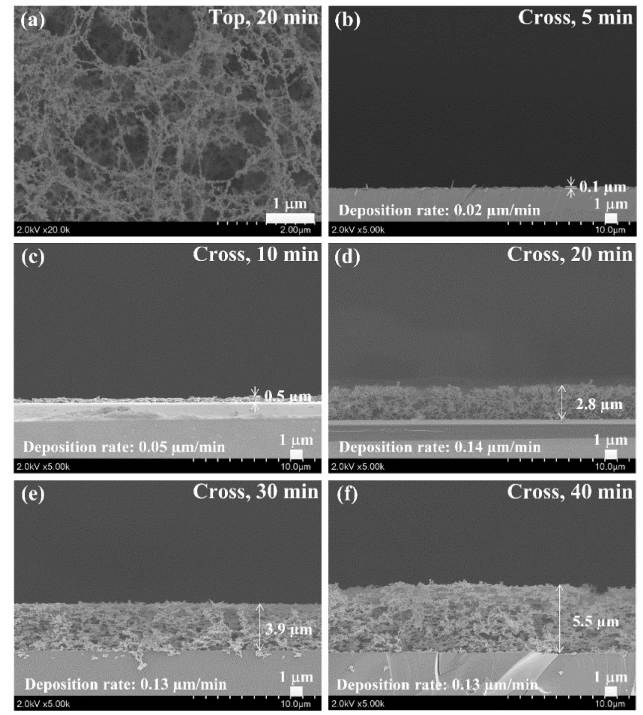
Figure 4. Scanning electron microscopy (SEM) images of plasma-polymerized aniline (pPANI) nanofibers with nanoparticles (NwN) thin film prepared via iPC-APPJ during various deposition times. ( a ) Top-view of pPANI after 20 min deposition; ( b )–( f ) cross-section view of pPANI at various deposition times. Scale bar = 1 µ